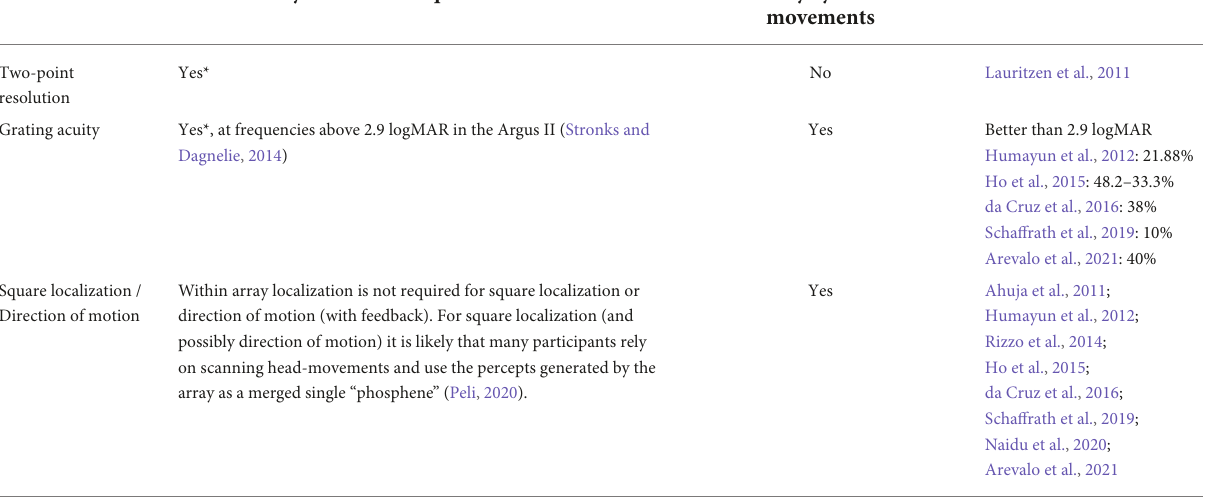
TABLE 7 Comparison of tasks used to measure spatial